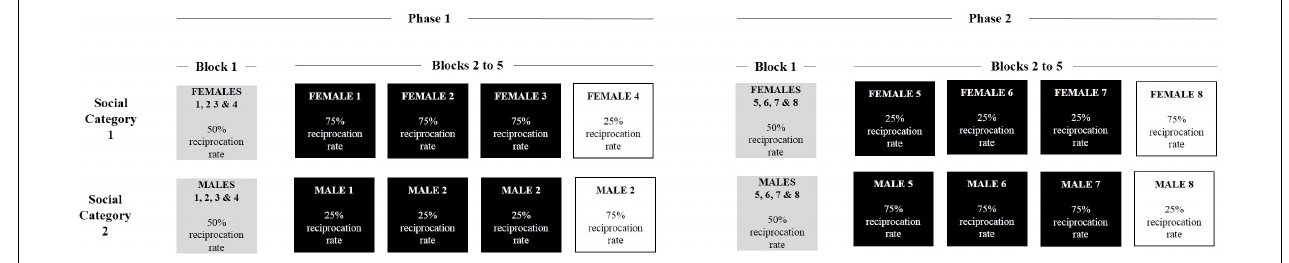
FIGURE 1 | Example of reciprocation rates in Study 1a, adapted from Cañadas et al.